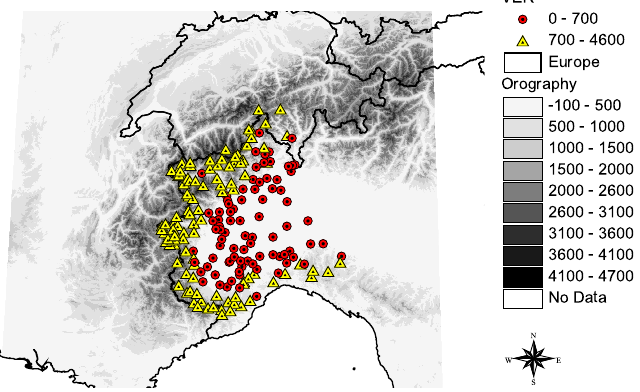
Fig. 2. Piemonte high resolution distribution for temperature sensors used for verification. The red dotes indicate stations below 700 m, the yellow triangles above.